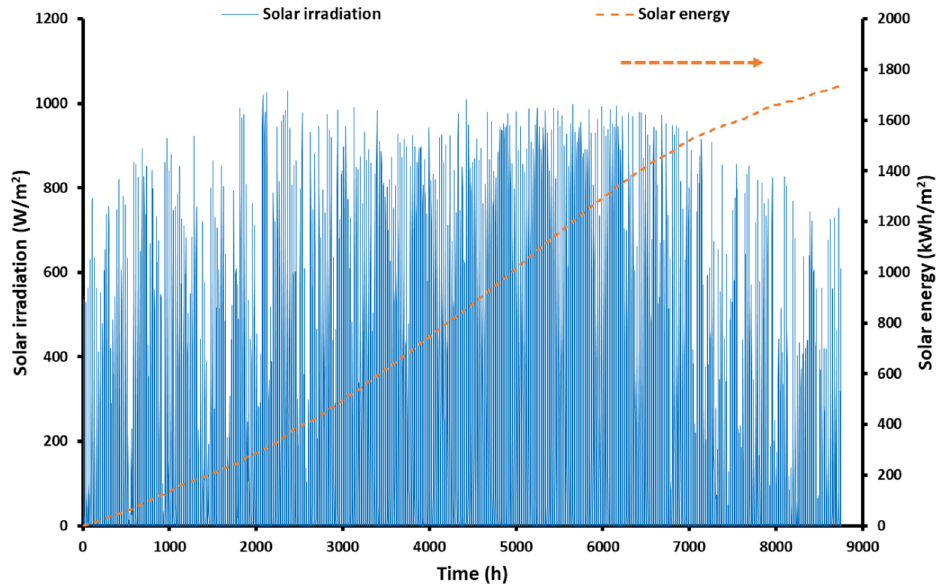
Figure 4. The solar irradiation variation on the tilted surface and the cumulative solar energy quantity per area for the examined location (Athens, Greece).